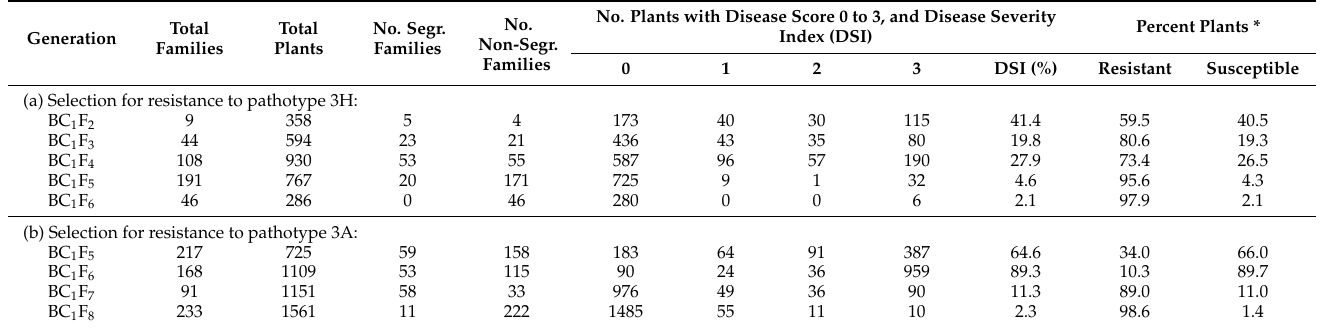
Table 1. Occurrence of plants resistant to Plasmodiophora brassicae (a) pathotype 3H and (b)